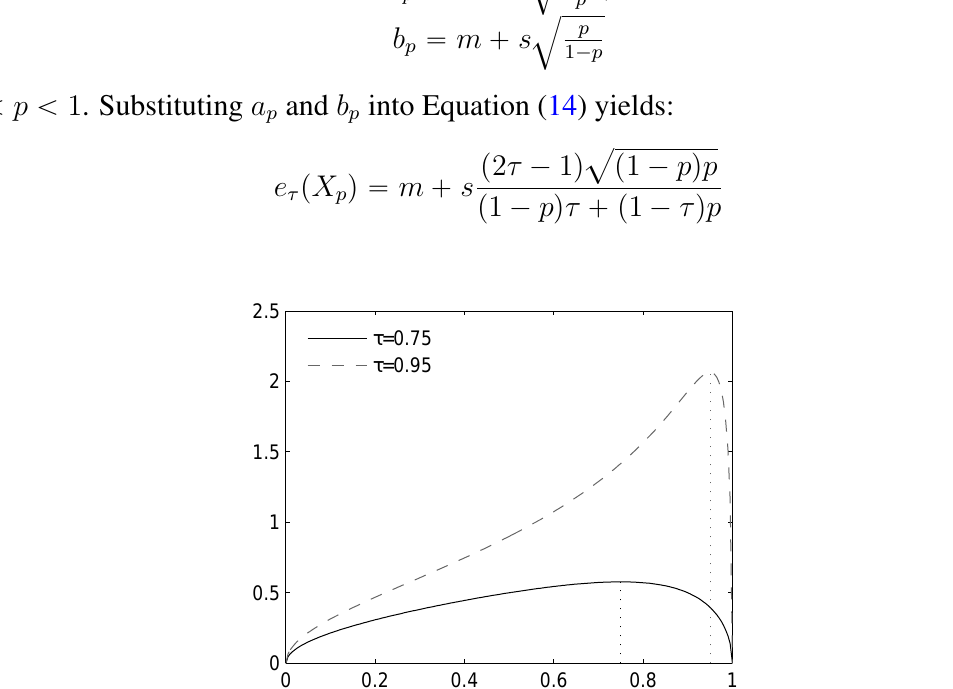
(standardized to m “ 0 , s “ 1 ), as a p